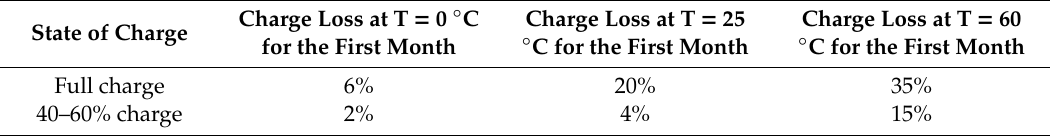
Table 1. Self-discharge rate of LiPo batteries for the first month